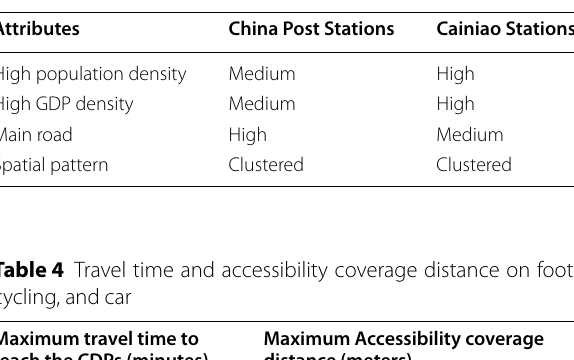
Table 3 Results of Getis-Ord Gi* cluster analysis